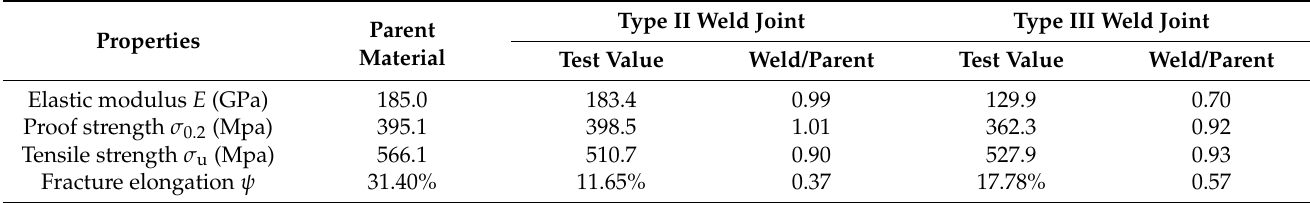
Table 10. Comparison of mechanical properties between parent material and weld joints.